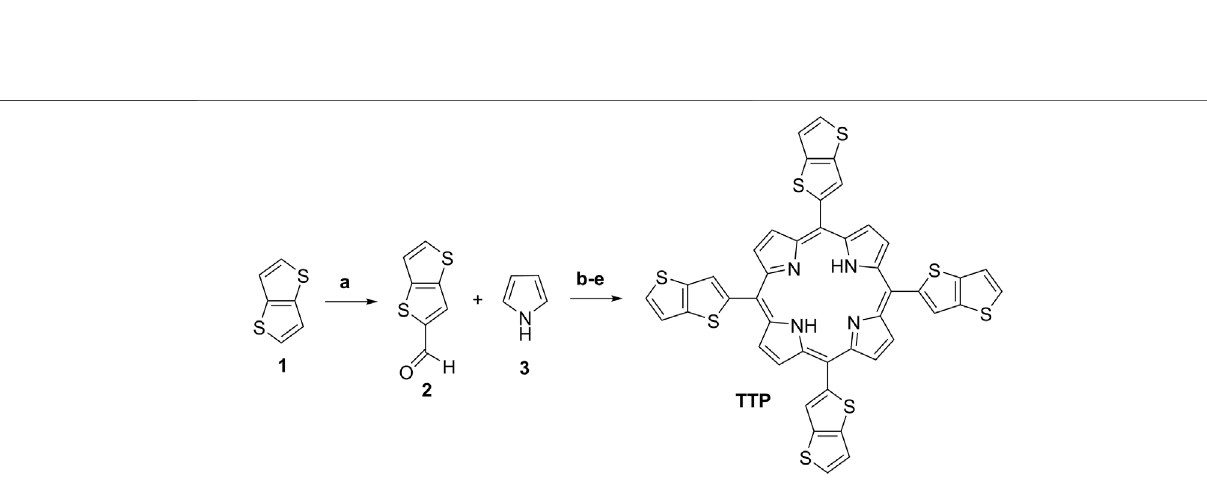
SCHEME 1 | Synthetic methods and the general structure of substituted thienyl-porphyrins.